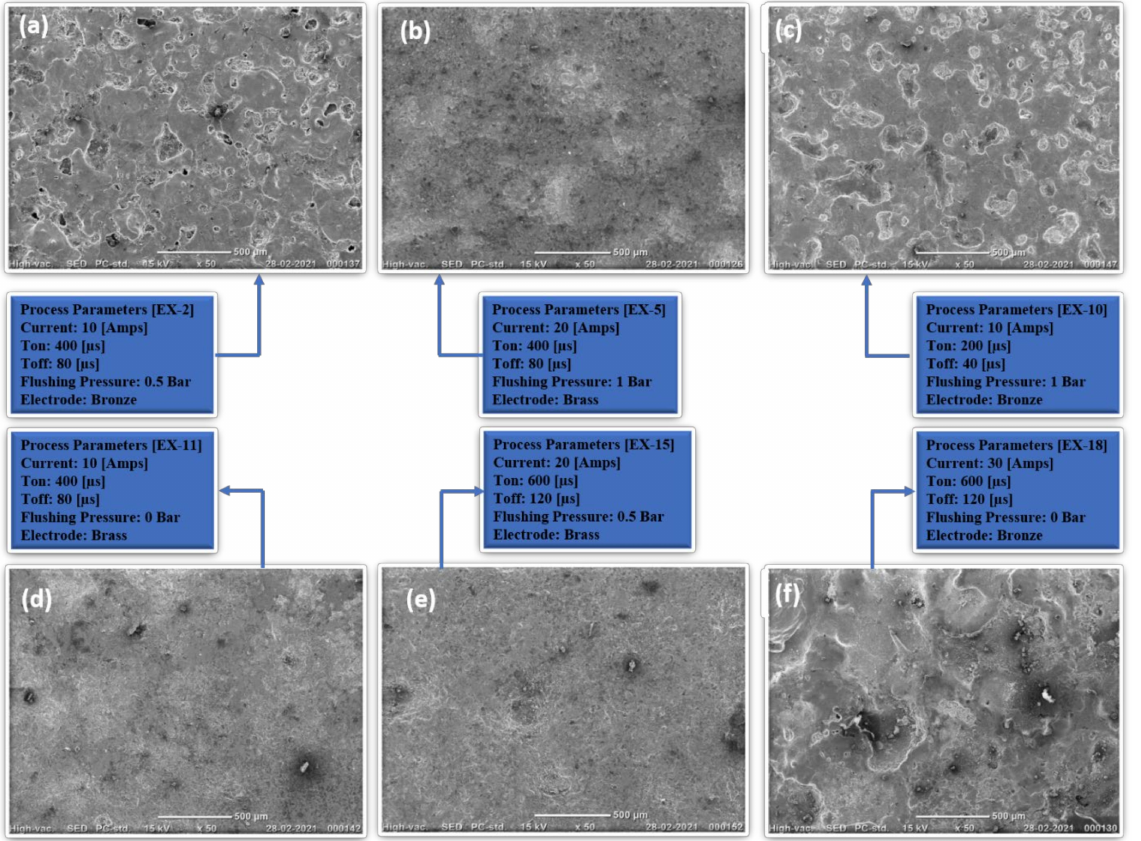
Figure 3. The morphology of EDCs: ( a ) EX 2, ( b ) EX 5, ( c ) EXP 10, ( d ) EX 11, ( e ) EX 15 and ( f ) EX 18 (all SEM images are 50 ×